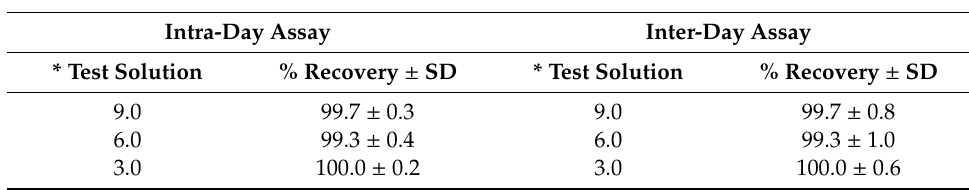
Table 4. Intra-day and inter-day assay of minocycline hydrochloride using a modified MCL-PM- ZnONPs-coated wire sensor